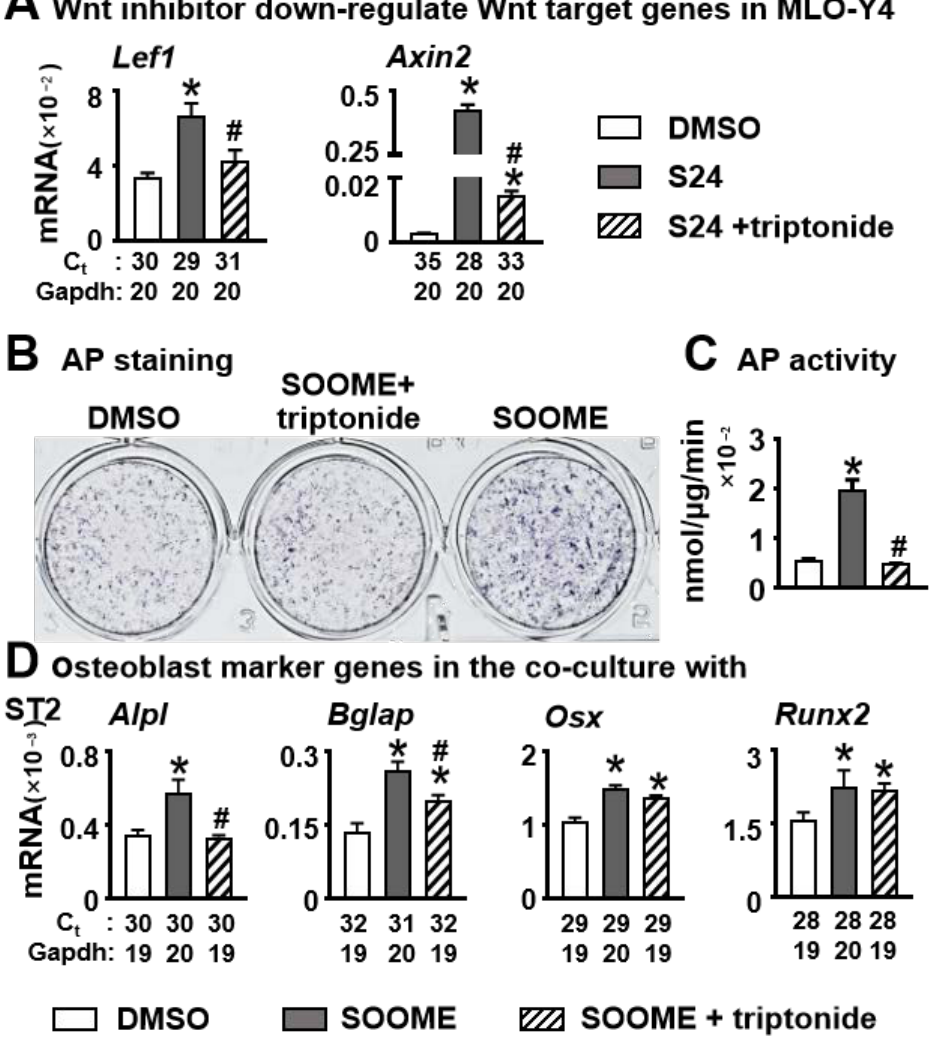
Figure 3. Effects of inhibition of Wnt/ β -catenin signaling in the SOOME on osteoblast differentiation. The SOOME was treated with or without Wnt inhibitor triptonide (10 nM) for 24 h. ( A ) qPCR detected the expression of Wnt target genes in the treated MLO-Y4 cells as indicated. Then the treated SOOME was co-cultured with ST2 cells for 3 days. Osteoblast differentiation was evaluated by ( B ) AP staining, ( C ) AP biochemical activity assay and ( D ) qPCR for the expression of osteoblast marker genes in co-culture system. The * symbol indicates p < 0.05 versus DMSO control and # indicates p < 0.05 versus SOOME by one-way ANOVA, Brown—Forsythe and Welch ANOVA tests and Kruskal—Wallis test; n = 3. Ct, cycle number detected by qPCR machine for a relative amount of target